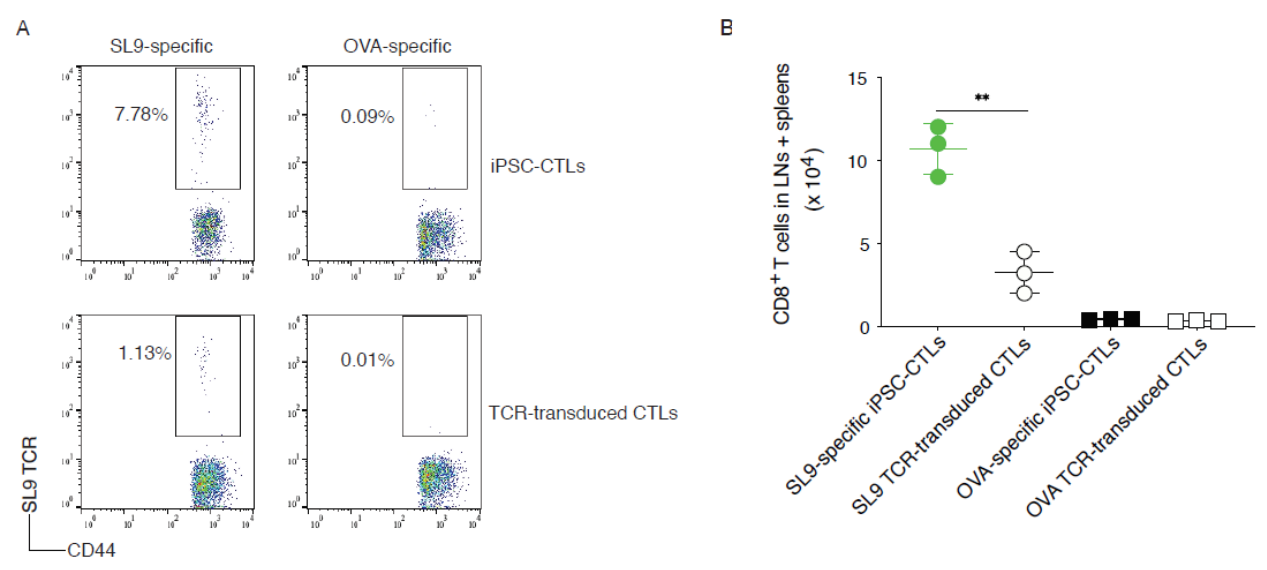
Figure 7. SL9-specific iPSC-CTLs persist in vivo. HHD mice were i.v. adoptively transferred with SL9 or OVA 257–264 -specific DsRed + CD8 + pre-iPSC-CTLs and in the following week were i.p. infected with EcoHIV. Eight weeks after EcoHIV infection, single cell suspensions were made from the spleens. ( A ) The spleen was analyzed for the T cell persistence. Persistent T cells by flow cytometry using CD44 and anti-human TCR staining, gating on CD8 + populations. Data shown are the representative of three identical experiments ( n = 5). ( B ) Number quantification of persistent CD8 + T cell population. The values represent mean ± S.E.M. (** p < 0.01, Unpaired t test).